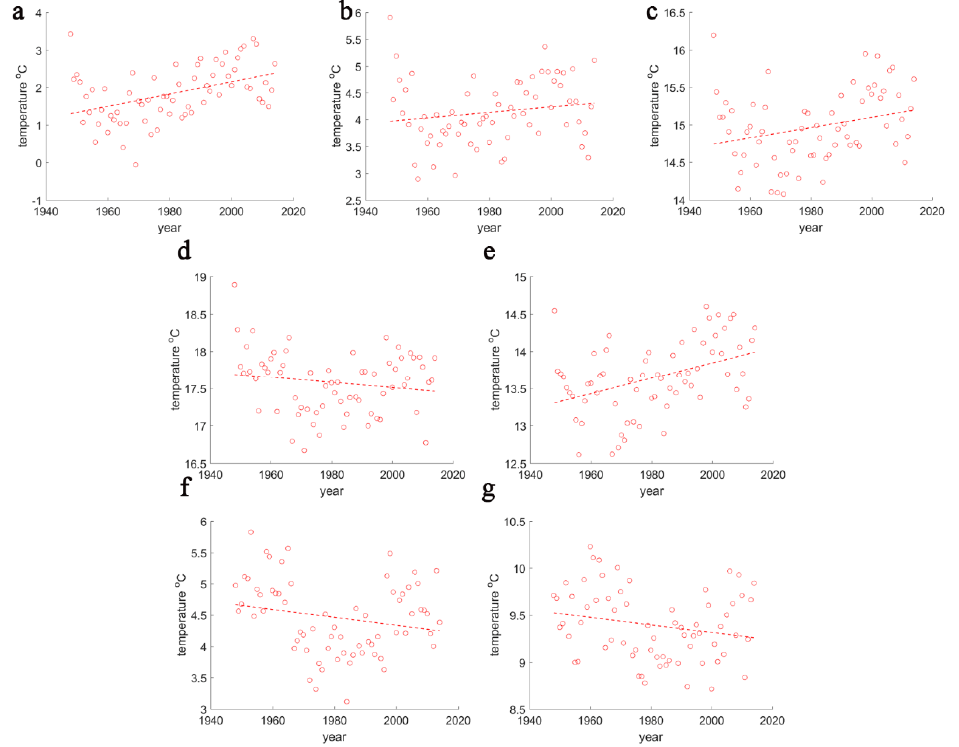
Figure 6. Inter-annual variation of air temperature for 1948 to 2014 in 7 regions of China. ( a ) NEC; ( b ) NC; ( c ) EC;( d ) SC; ( e ) CC; ( f ) NWC; ( g ) SWC.